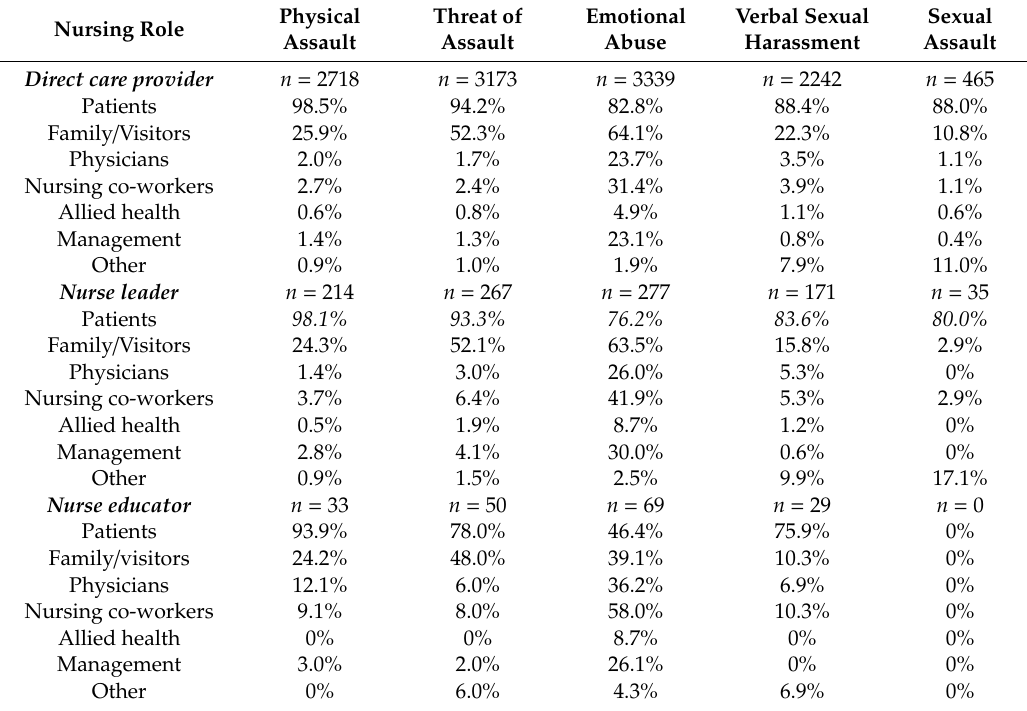
Table 5. Percentage of workplace violence compared individually by